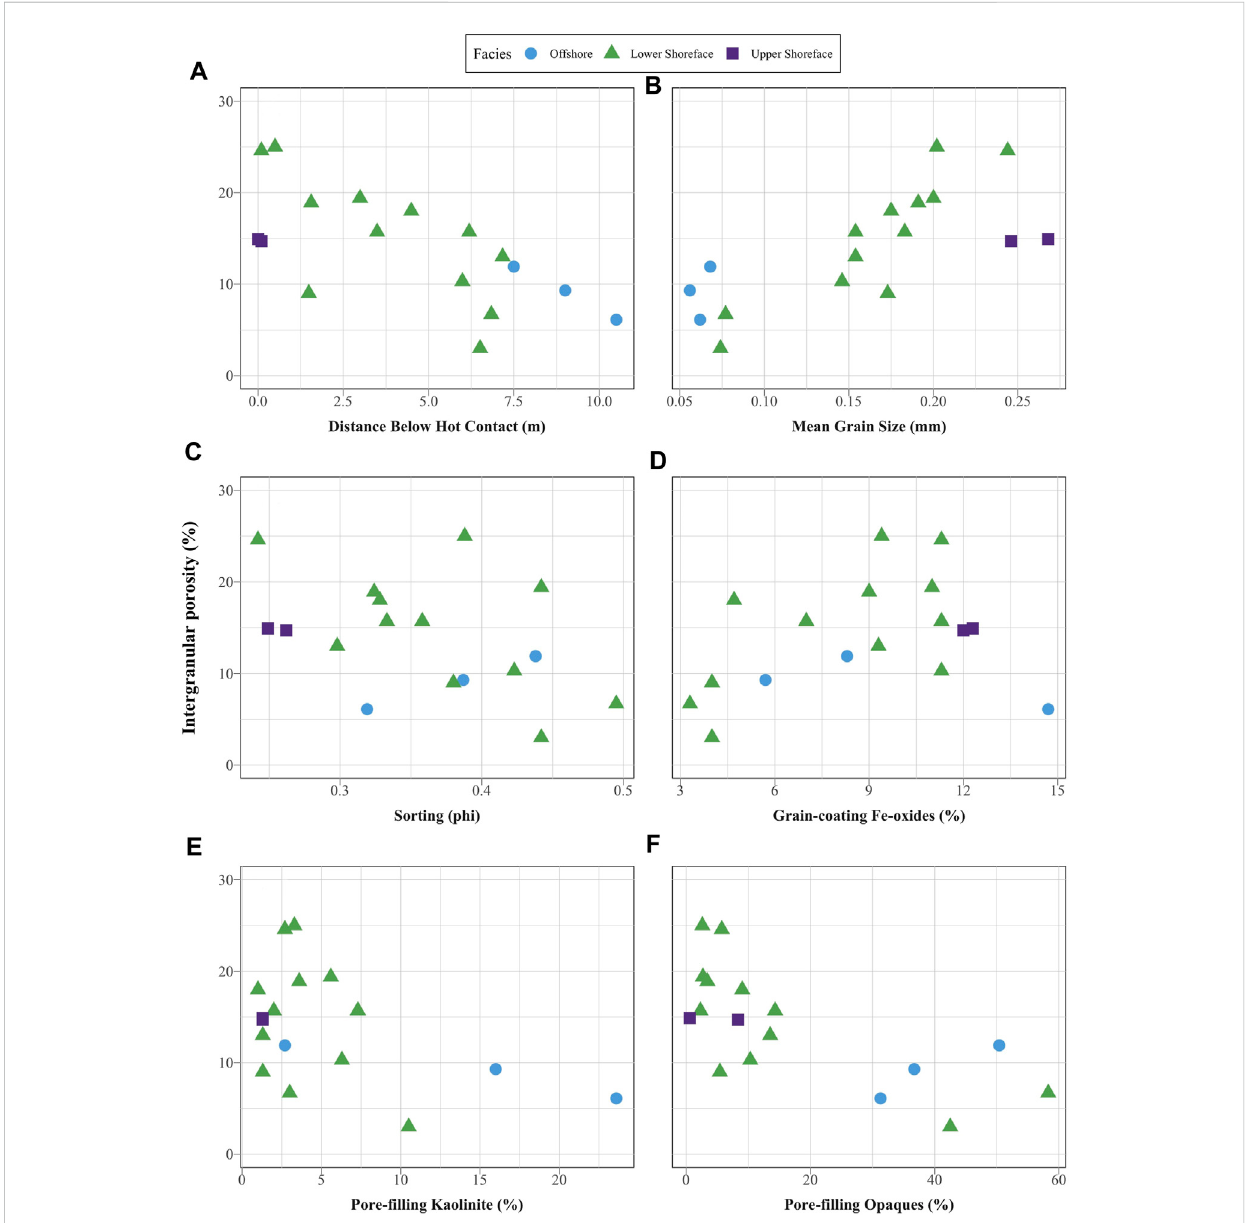
FIGURE 18 Controlsonintergranular porosity. (A) Anincreaseinporositytowardsthesillcontact. (B) Anincreaseinporositywithincreasingmeangrainsize. (C) An increase in porosity with better sorting. (D) An increase in porosity with increasing amount of grain-coating Fe-oxide minerals. (E) A decrease in porosity with increasing kaolinite content. (F) A decrease in porosity with increasing pore- fi lling Fe-oxide content.